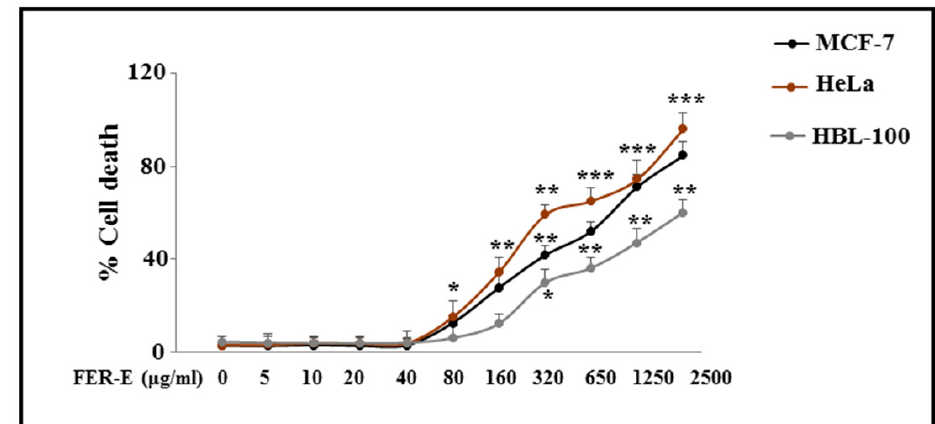
Figure 2. Comparison of FER-E induced cell mortality in different cell lines. The curves shown in the figure are related to mortality caused by treatment with FER-E (80–2500 µ g/mL) at different con- centrations, for 24 h, in three cell lines (MCF-7, Hela and HBL-100). Three independent experiments were carried out, and the values were expressed as the mean ± sd. * denotes p < 0.05 vs. the control; ** denotes p < 0.01 vs. the control; *** denotes p < 0.001 vs. the control. Analysis of Variance (ANOVA) was followed by a Tukey–Kramer comparison